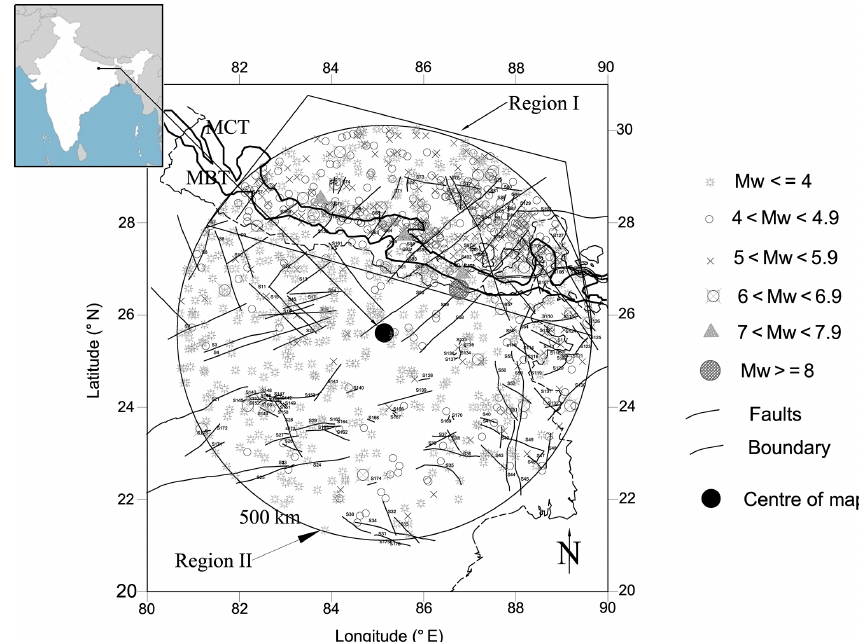
Figure 1. Seismotectonic map of Patna